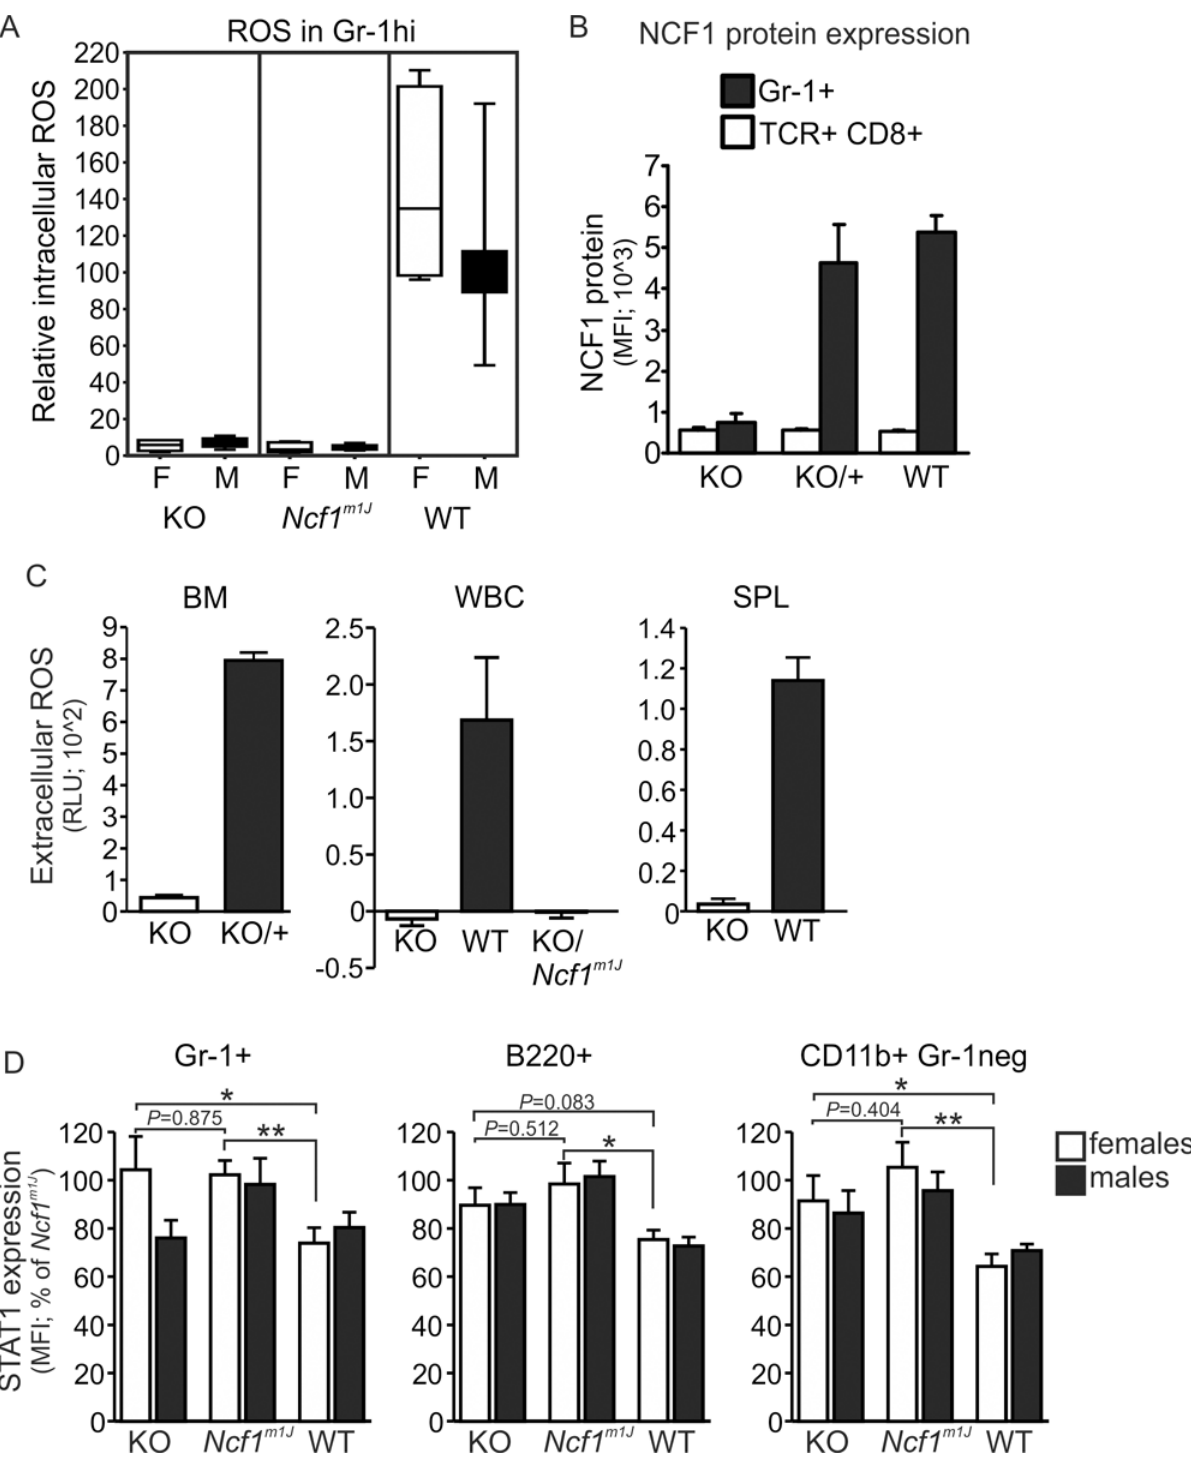
Fig 1. Ncf1 knockouts and Ncf1 m1J mice are deficient in ROS production and share the interferon signature. (A) Intracellular ROS production is absent in blood granulocytes from Ncf1 -deficient mice. Blood leukocytes from Ncf1 knockouts (KO), wild types (WT) and mice with the Ncf1 m1J mutation were stained for surface markers and stimulated by PMA. Intracellular ROS production was quantified as dihydrorhodamine-123 fluorescence by flow cytometry. F = females, M = males. (B) Ncf1 knockouts do not express the NCF1 protein in blood granulocytes (Gr-1+) when analyzed by intracellular staining and flow cytometry. T cells (CD3+CD8+) were used as negative control. (C) Ncf1 knockouts fail to respond to PMA stimulation by extracellular ROS